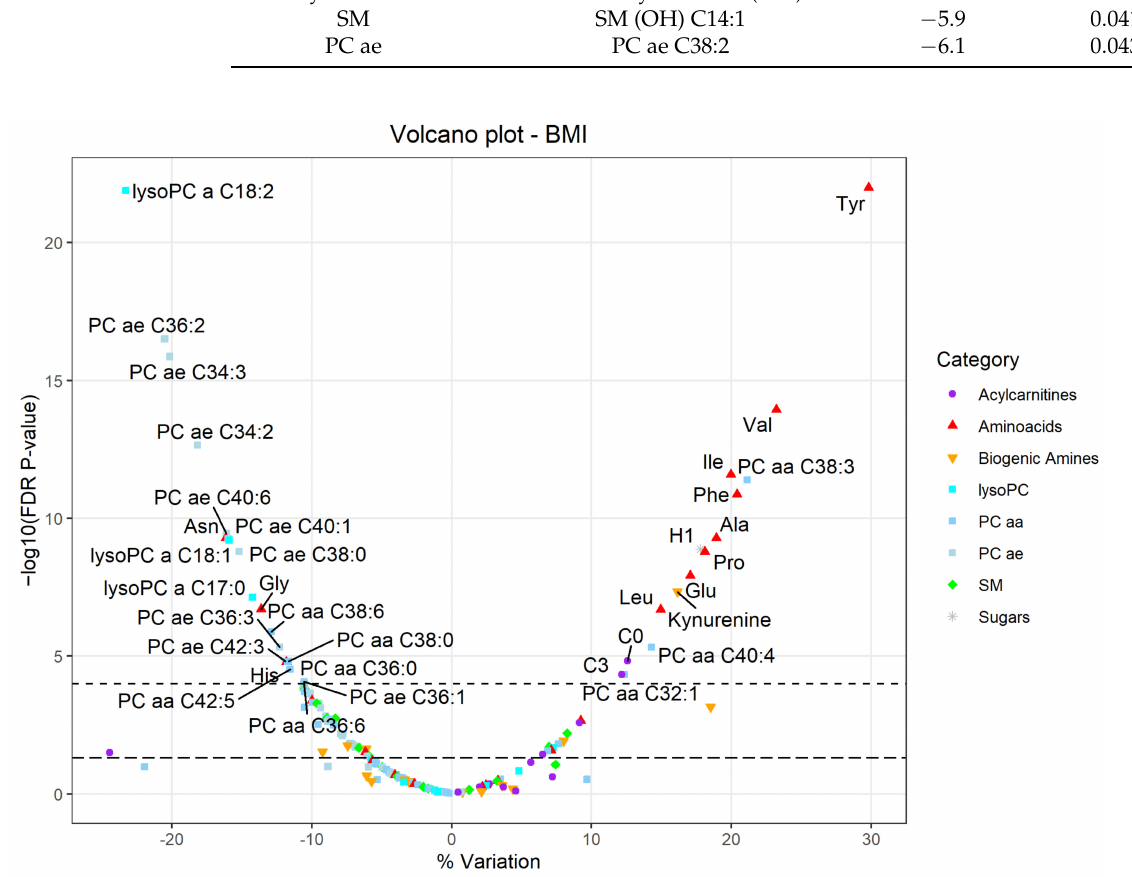
Figure 1. Volcano plot representing the results of the Tobit linear regression models considering the metabolites (dependent variables) in relation to BMI (independent variable), adjusted for age, sex, and smoking habit. Each dot represents a metabolite and they are displayed based on the % variation ( ∆ % = (exp( β ) − 1) × 100) ( x -axis) and the negative logarithm (base 10) of the FDR p -value ( y -axis). The upper dashed line represents an FDR p -value equal to 0.0001, while the lower dashed line represents an FDR p -value equal to